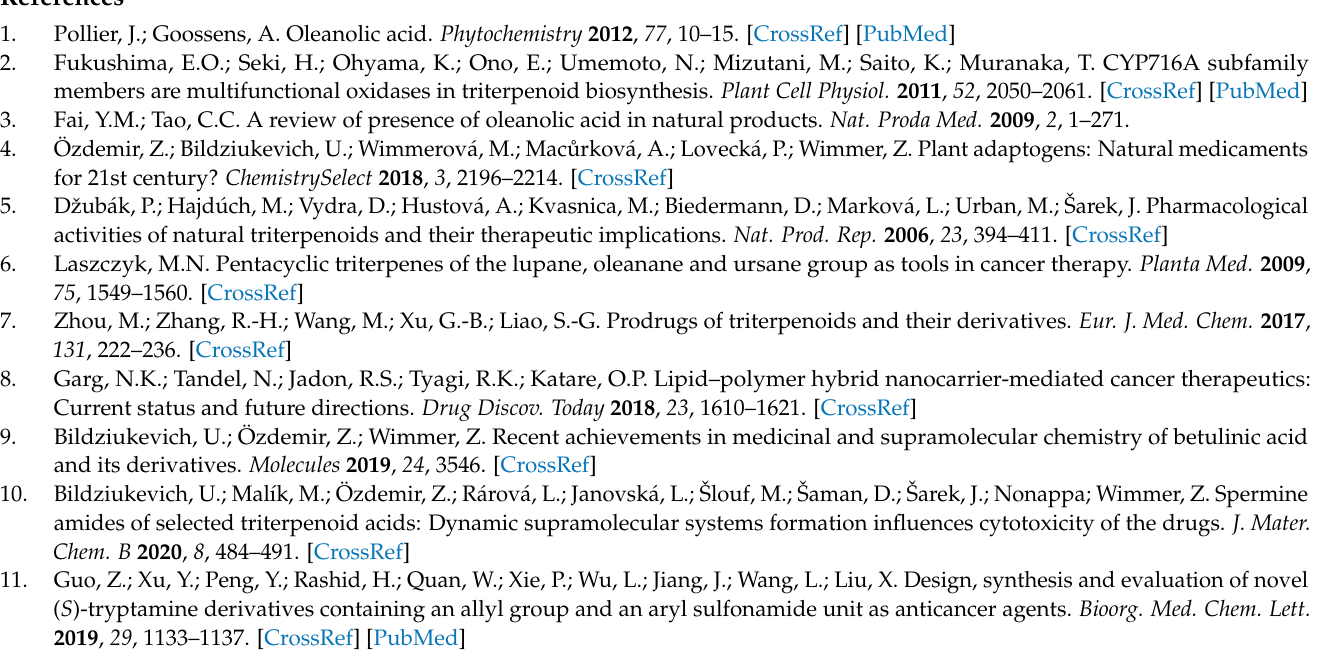
Figure S3: Activity of caspase-3/7 after 24 h treatment with 3a–3c (3, 10 and 30 µ M) in G-361 cells. Figure S4: Graphs of CVS active/inactive drugs. Figure S5: UV spectra of the selected compounds studied. Graph S1: Blotted membranes with proteins colored by